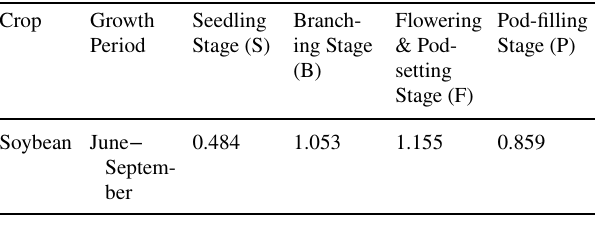
Table 5 Soybean coefficients during different growth stages in the Huaibei Plain study area in Anhui Province,